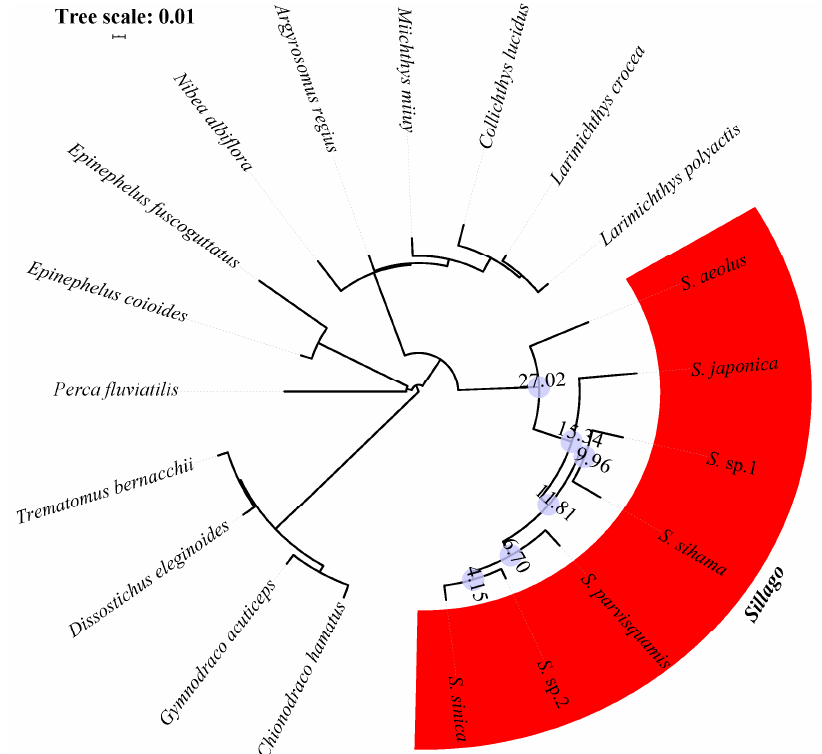
Figure 3. Inferred phylogenetic relationships and divergence times (data in the blue circles) of the seven Sillago species based on the concatenated amino acid sequences.